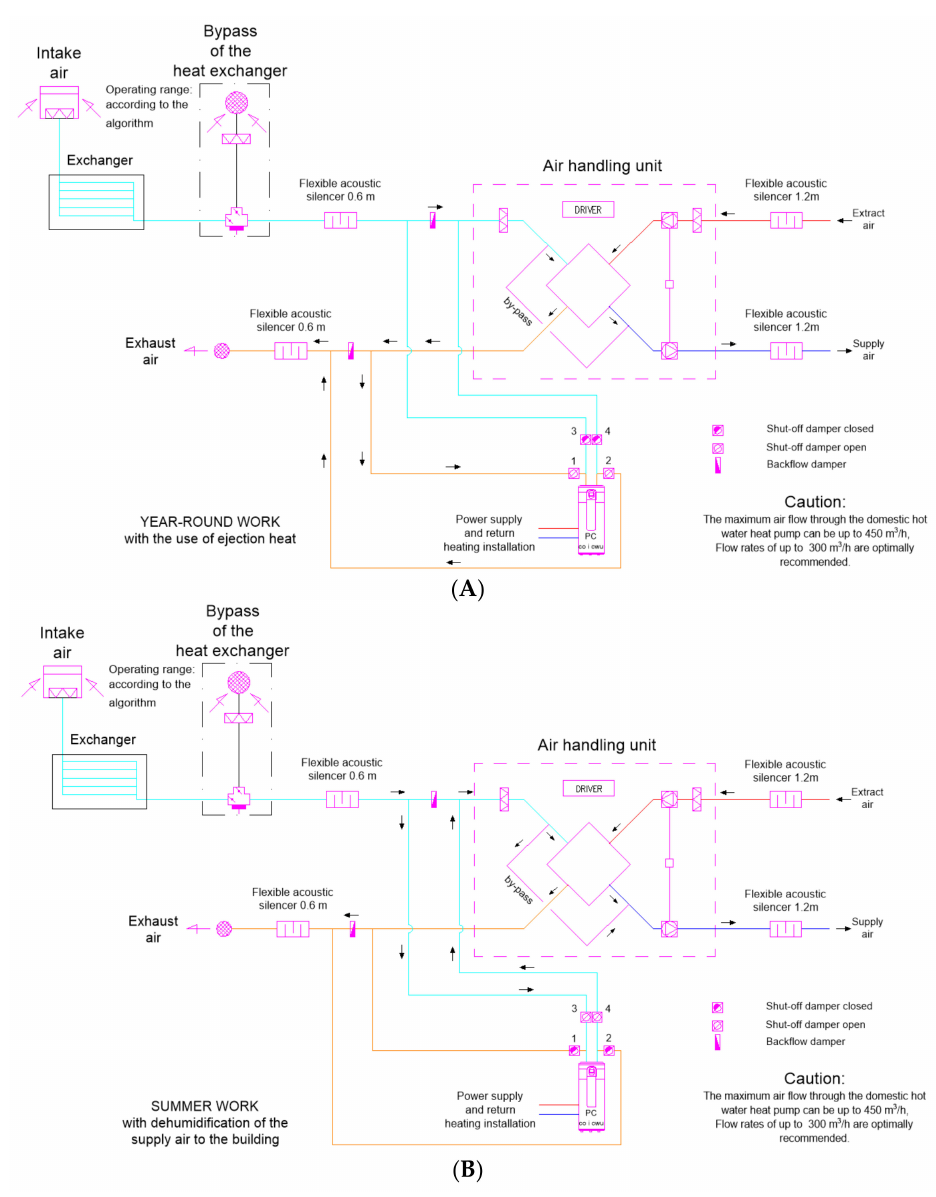
Figure 4. ( A ) Diagram of GGAHE integration with the heat pump—year-round mode. ( B ) Diagram of GGAHE integration with the heat pump—summer